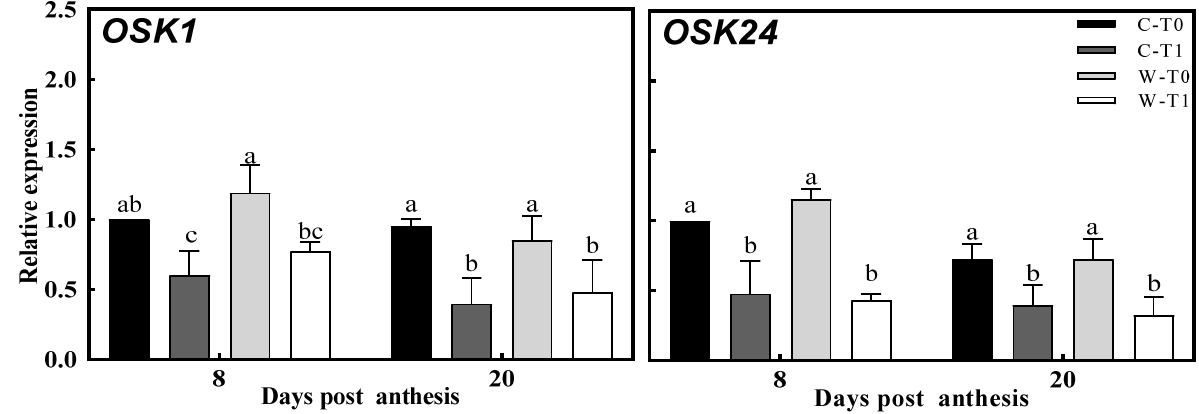
Figure 5. Gene expression with regards to the regulation of SnRK1 level in the stems of 2020. The expressions of OSK1 and OSK24 in the regulation of SnRK1 level were validated by RT-PCR. C, CJ03; W, W1844; T0, control group; T0, control group without any treatment; T1, top 2/3 of the spikelets were removed; different letters from the same character under the same DPA indicate significant differences at the p = 0.05 level.